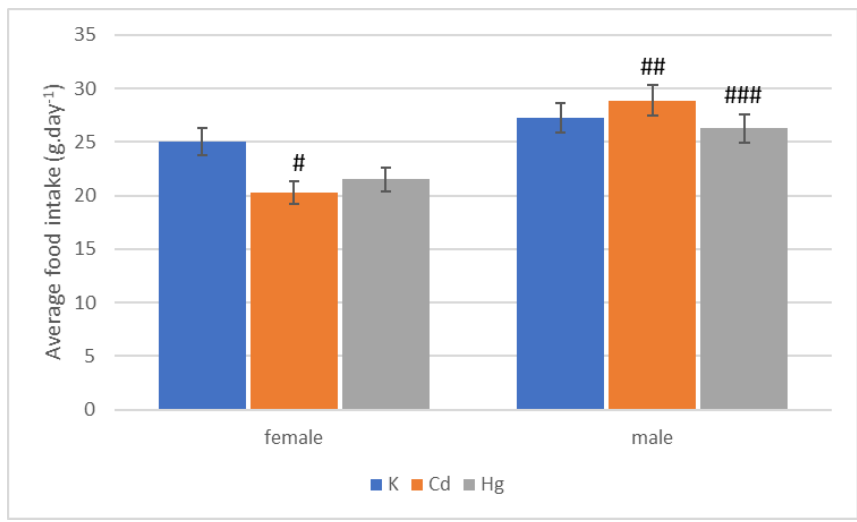
Figure 3. A comparison of food intake after 52 weeks of the experiment. # p < 0.05, for K female group compared to Cd female group; ## p < 0.001, for Cd female group compared to Cd male group; ### p < 0.05, for Hg female group compared to Hg male group; n = 8 per group.